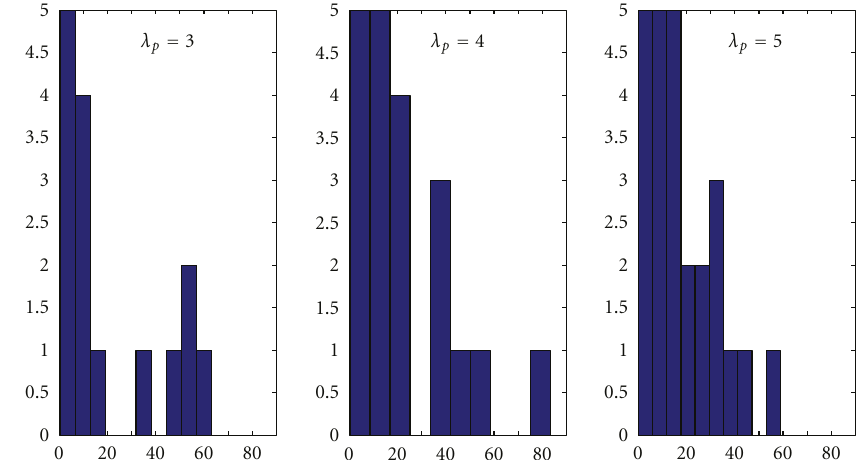
Figure 8: Primary users’ spectrum utilization.